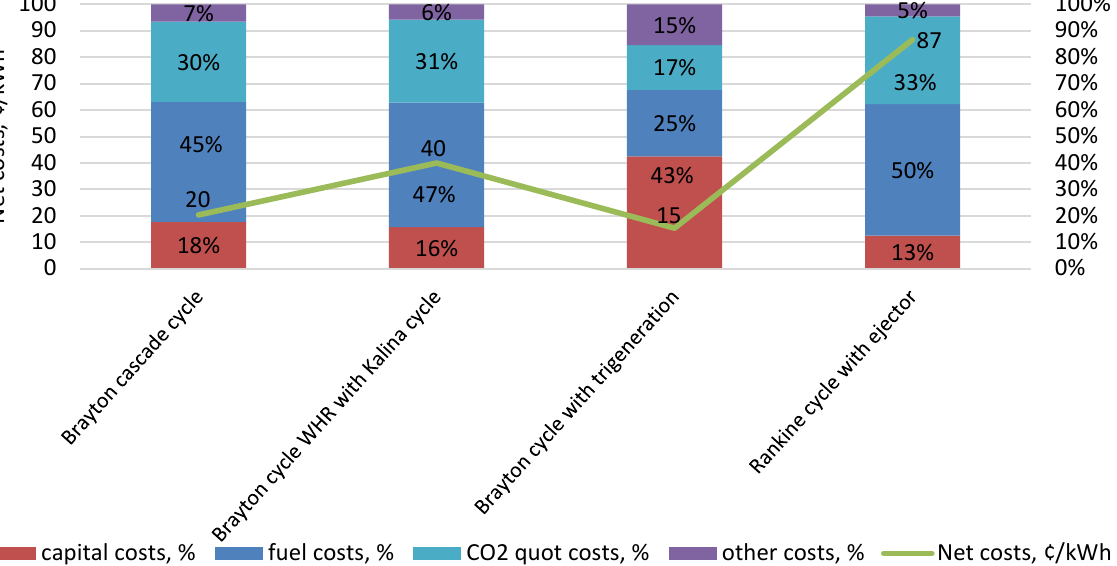
Figure 36. Cost of electric power generated with regeneration CO 2 power cycles at the cost of CO 2 emission quotas of 100 $/ton for microgeneration.